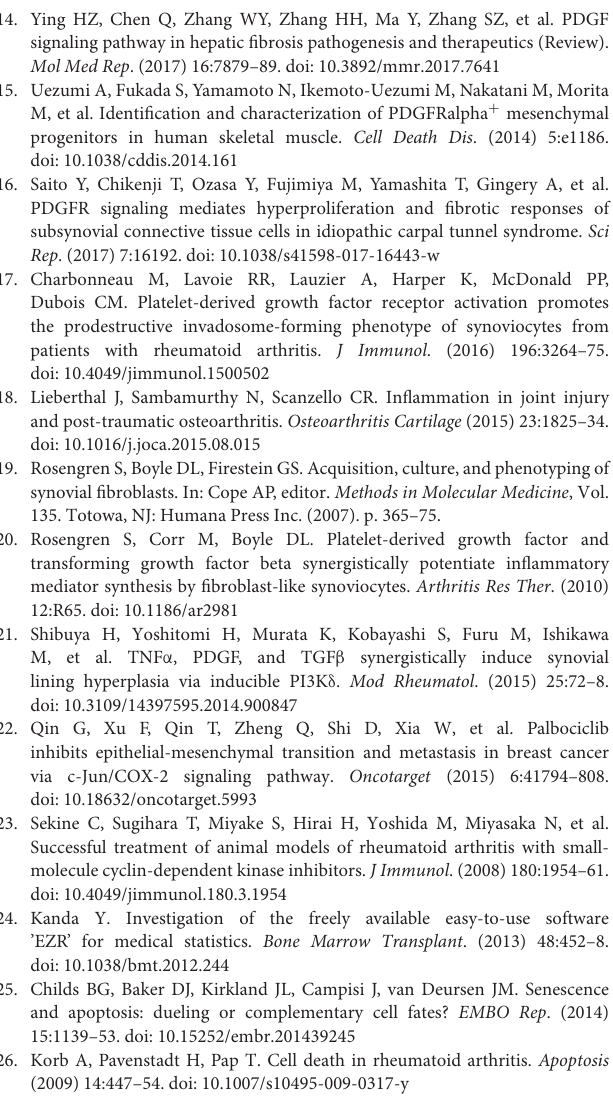
Supplemental Figure 4 | Cell proliferation assay by using PDGF-BB, TGF- β , and TNF- α stimulation of RA-FLS. The stimulation with PDGF-BB, TGF- β , and TNF- α stimulation did not show significant difference in RA-FLS. One-way ANOVA was used for statistical analysis. The significance level was P < 0.05. Supplemental Figure 5 | Normalized expression of pPDGFR αβ and CDH11 expression by using 2GF + TNF, and etanercept and palbociclib in RA-FLSs. (A,B) Normalized expression of pPDGFR αβ and CDH11 in RA-FLSs stimulated with PDGF-BB, TGF- β , and TNF- α in each combination. (C,D) Normalized expression of pPDGFR αβ and CDH11 in RA-FLSs stimulated with 2GF + TNF, and etanercept and palbociclib in each combination. One-way ANOVA was used for statistical analysis. The significance level was P < 0.05. Supplemental Figure 6 | Correlation between the percentages of cells expressing pPDGFR αβ and/or CDH11, and the characteristics of patients. The percentages of cells expressing pPDGFR αβ and/or CDH11 did not correlate with age or sex. Correlations were examined statistically by using Pearson’s correlation coefficient. The significance level was P <